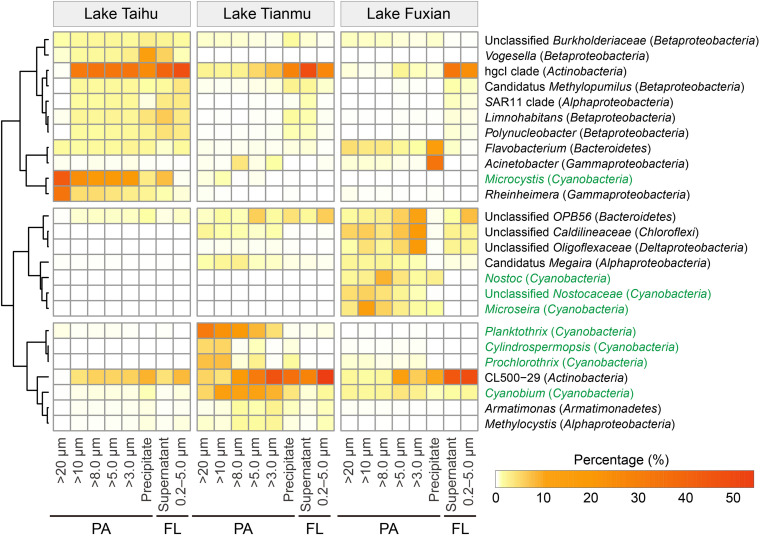
Heatmap of the 25 major genera, including the top 10 genera in each lake. Genera in green are associated with the photosynthetic autotrophic Cyanobacteria. PA, particle-attached; FL, free-living.